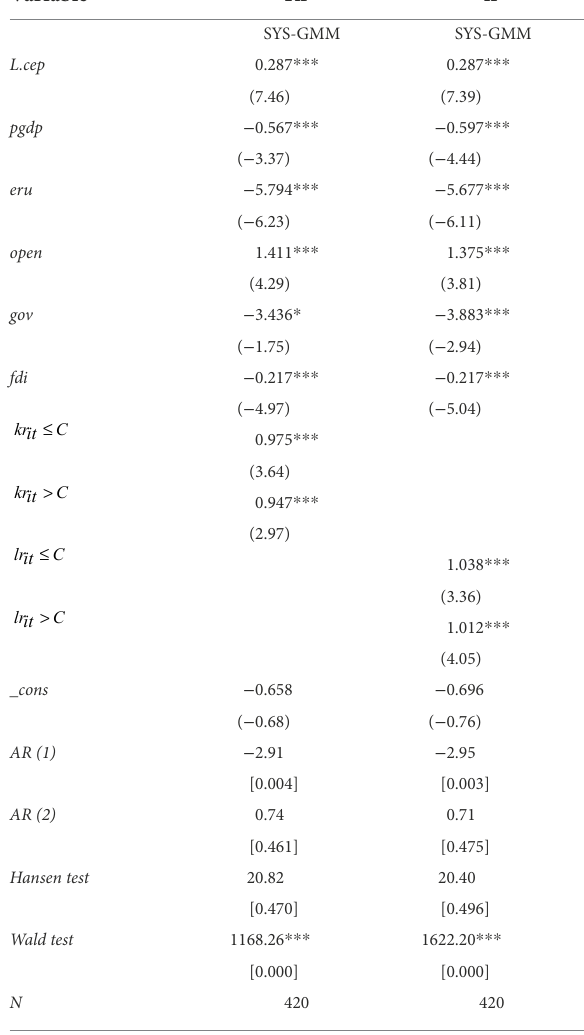
TABLE 6 The results of threshold model.